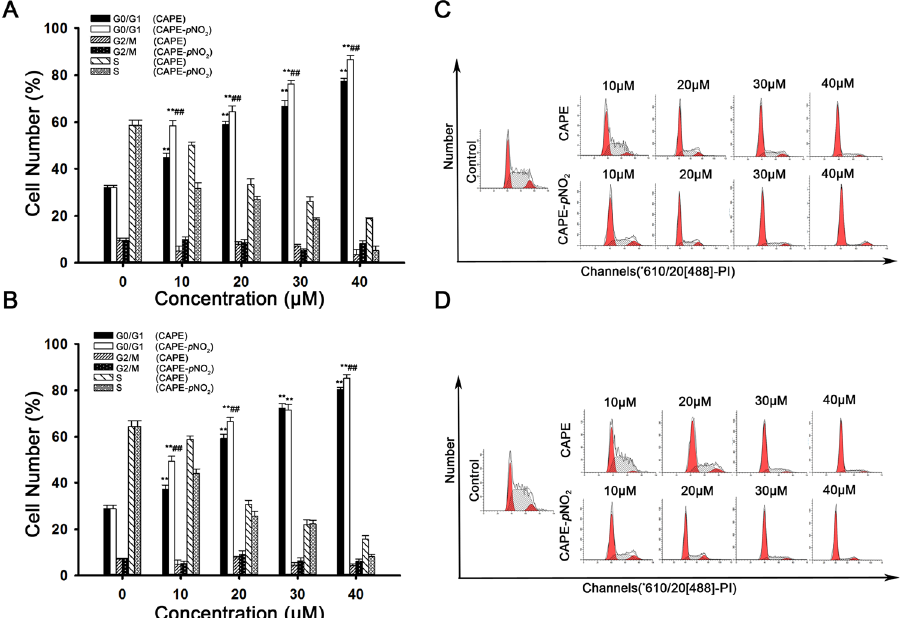
Figure 3. CAPE and CAPE- p NO 2 induce cell cycle arrest at the G0/G1 phase in colon cancer cells. The percentage of cells in G0/G1, S and G2/M phase was calculated using Multicycle software. Changes in the cell cycle distribution in HT-29 (A) and HCT-116 (B) cells after treatment for 48 h with the concentration from 0 to 40 μ mol/L. HT-29 (C) and HCT-116 (D) cells were stained with PI and were analysed by flow cytometry. The data represented the means ± SD from three independent experiments, and error bars represented with STDEV (SD). * p < 0.05, ** p < 0.01: CAPE and CAPE- p NO 2 compared with the control. # p < 0.05, ## p < 0.01: CAPE- p NO 2 compared with CAPE at the same